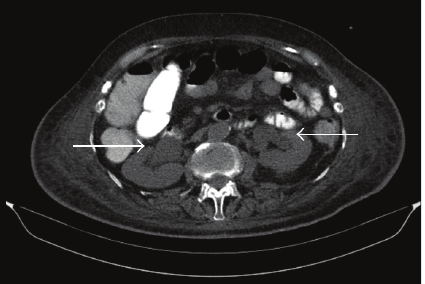
Figure 2: Rectus Sheath Hematoma : distension of renal pelvic system